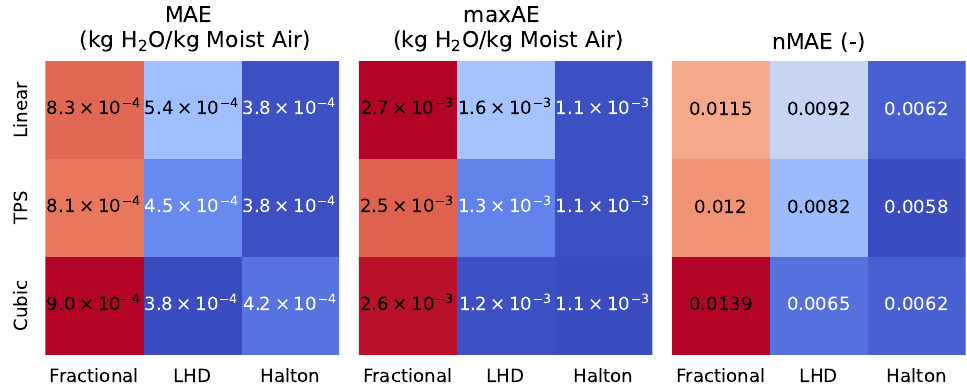
Figure 6. Left : MAE of the water mass fraction averaged for all 18 operating points for the combina- tions of DoCE and approximation method. Middle : maximum error of the water mass fraction inside the humidifier for the combination of DoCE and approximation method. Right : nMEA averaged over the 18 validation